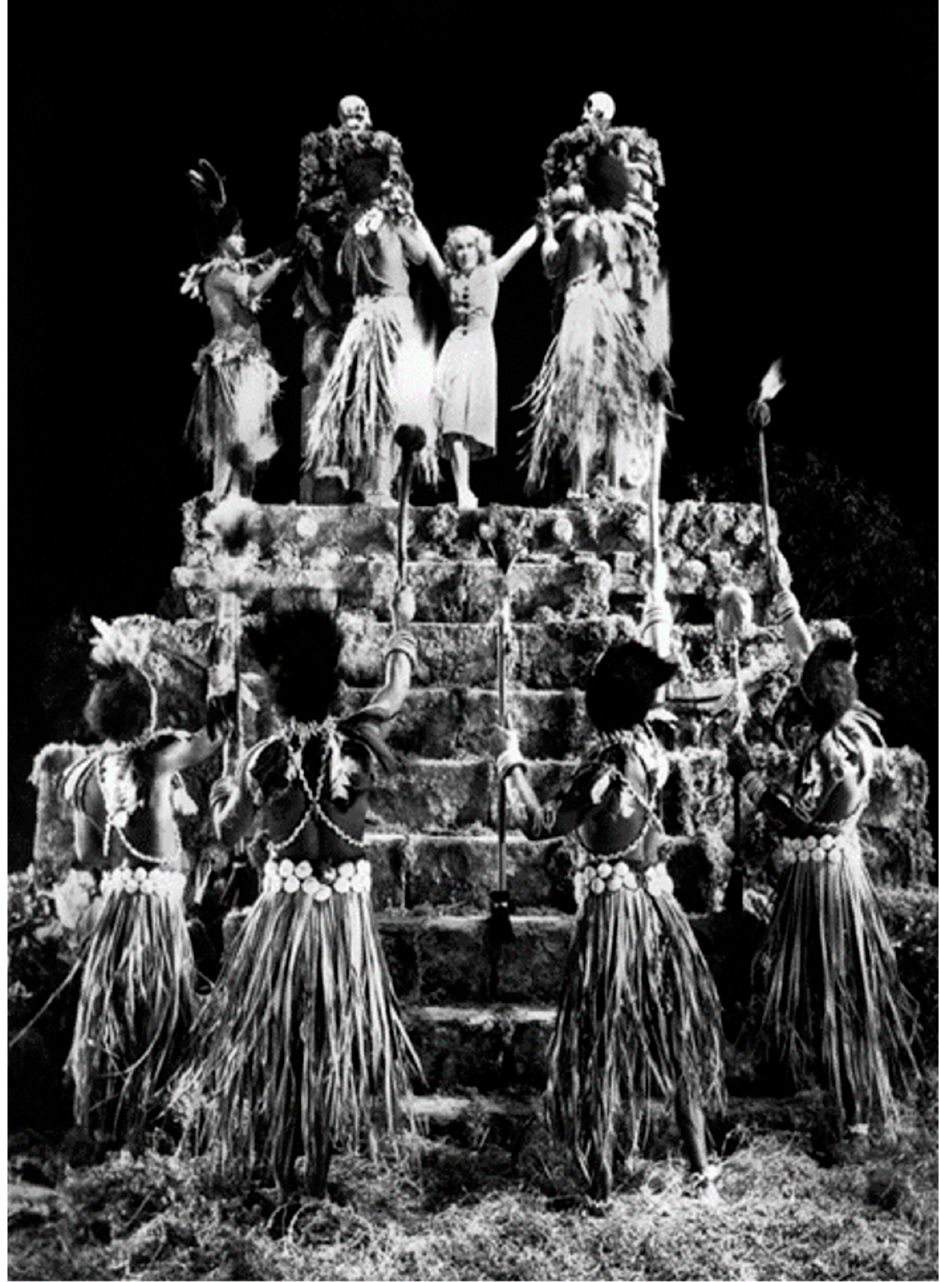
Figure 23. The blonde woman is sacrificed on an altar (1933). https://www.pinterest.es/pin/354165958186059607/ (accessed on 1 January 2021).